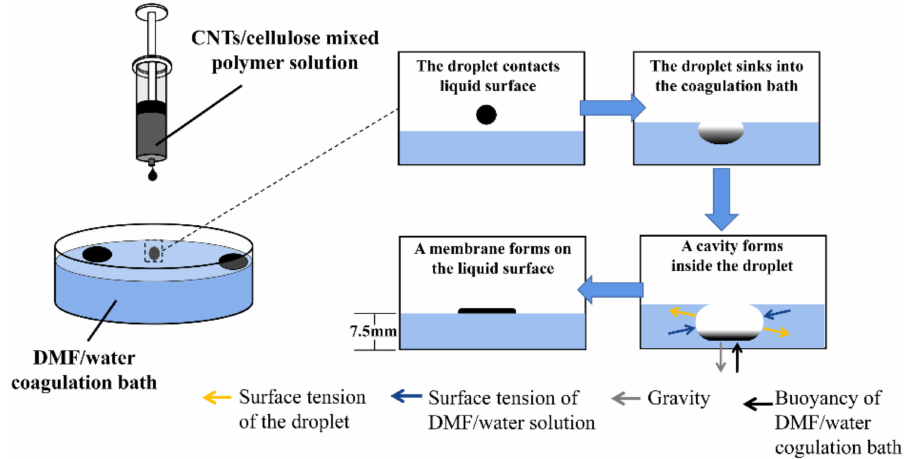
Figure 1. Schematic diagram of the preparation of the cellulose/CNTs